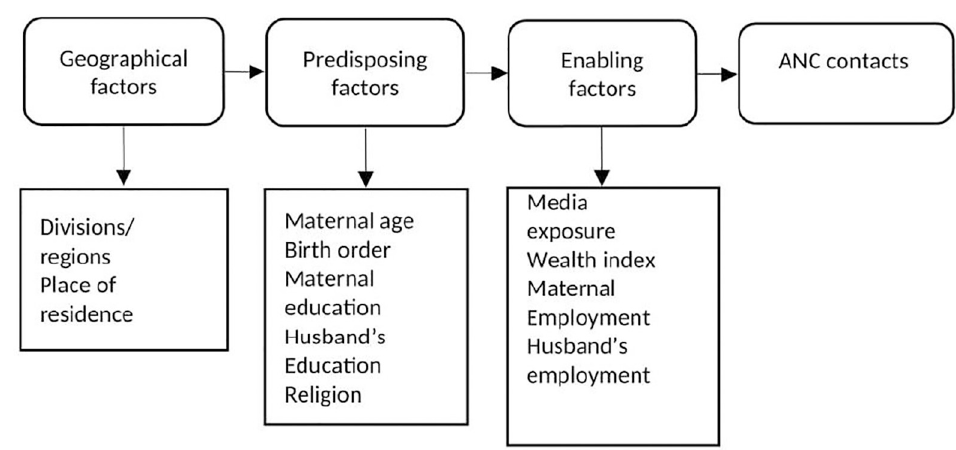
Fig 1. Analytical framework of factors associated with ANC contacts in Bangladesh. Adapted from Andersen [25].